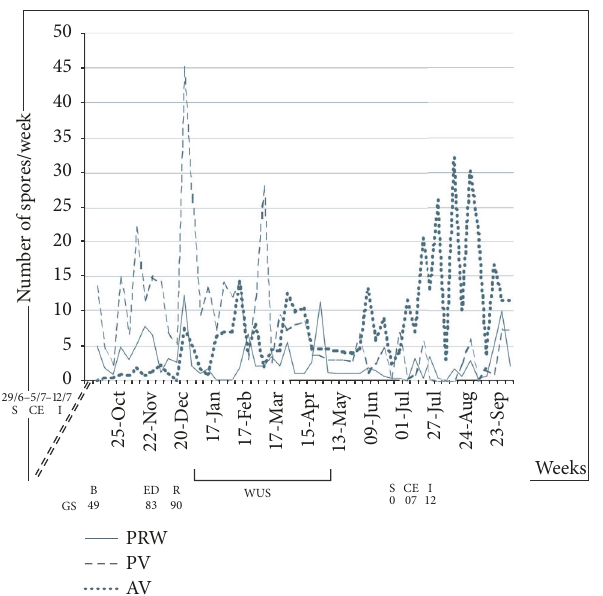
Figure 5: Number of PRW, PV, and AV of Zymoseptoria tritici during the first period. The wheat crop was harvested on December 20, 1998. References: type of spores: PRW: pycnidiospores in rain water; PV: pycnidiospores in Vaseline; AV: ascospores in Vaseline. Growth stages of wheat following Zadoks et al. 1974: S (sowing); CE (coleoptile emergency); i (inoculation); B (boot); ED (early dough grain); R (ripening); WUS (wheat unburied stubble); dates corresponding to each activity and growth stage in the field.